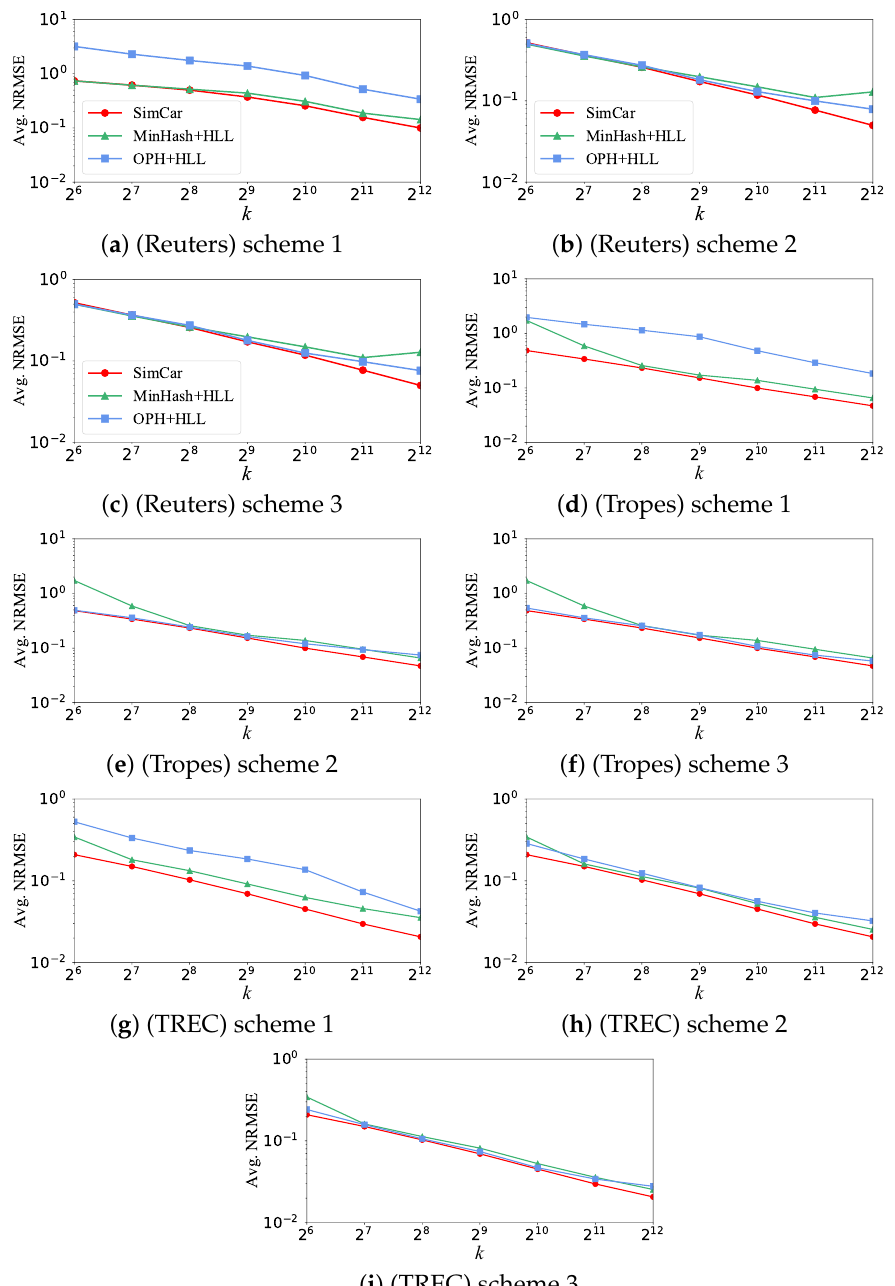
Figure 7. Average NRMSEs of SimCar compared with MinHash and HLL and OPH and HLL for estimating common-interest